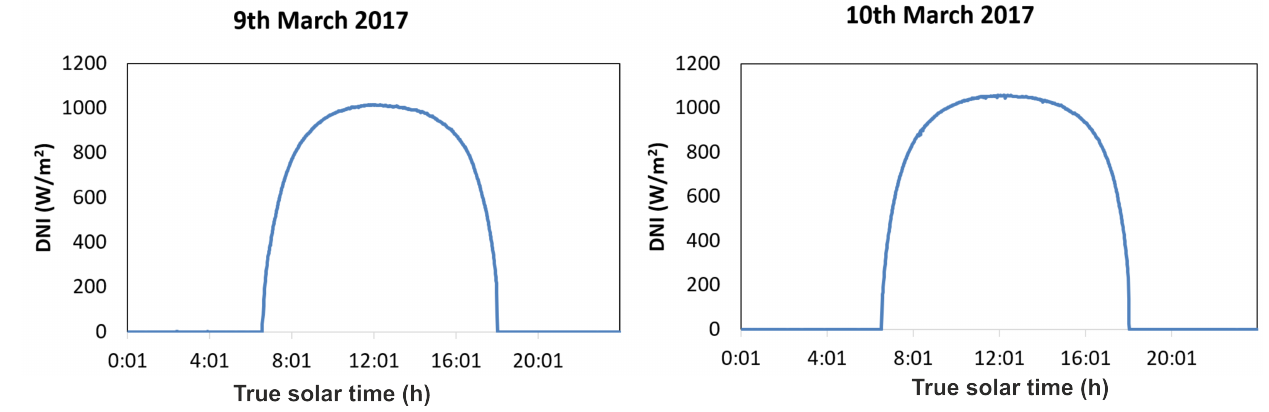
Figure 4. DNI measured on 9 and 10 March 2017 at the PSA